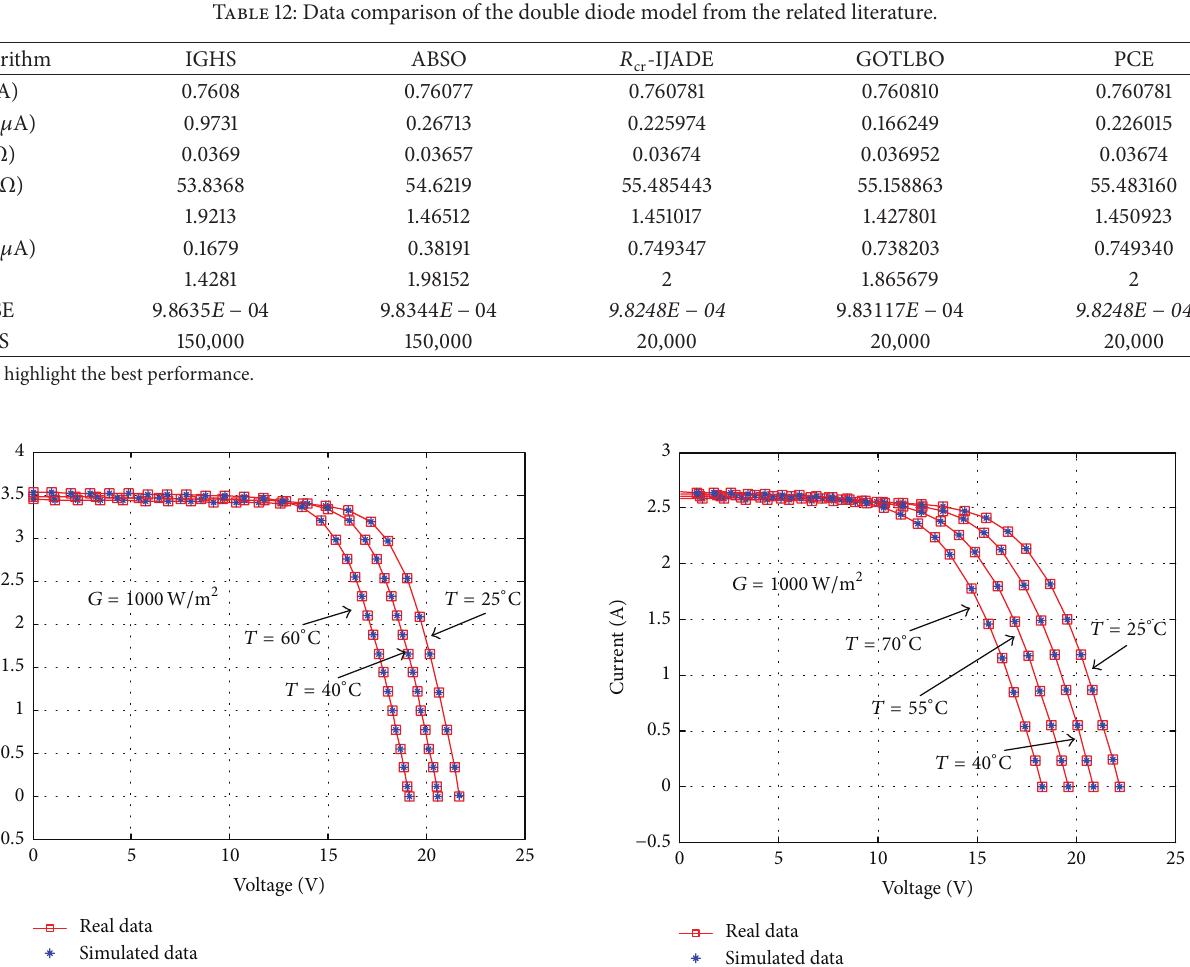
Figure 8: Comparison between real data and the simulated data by PCE for thin-film ST40 at different